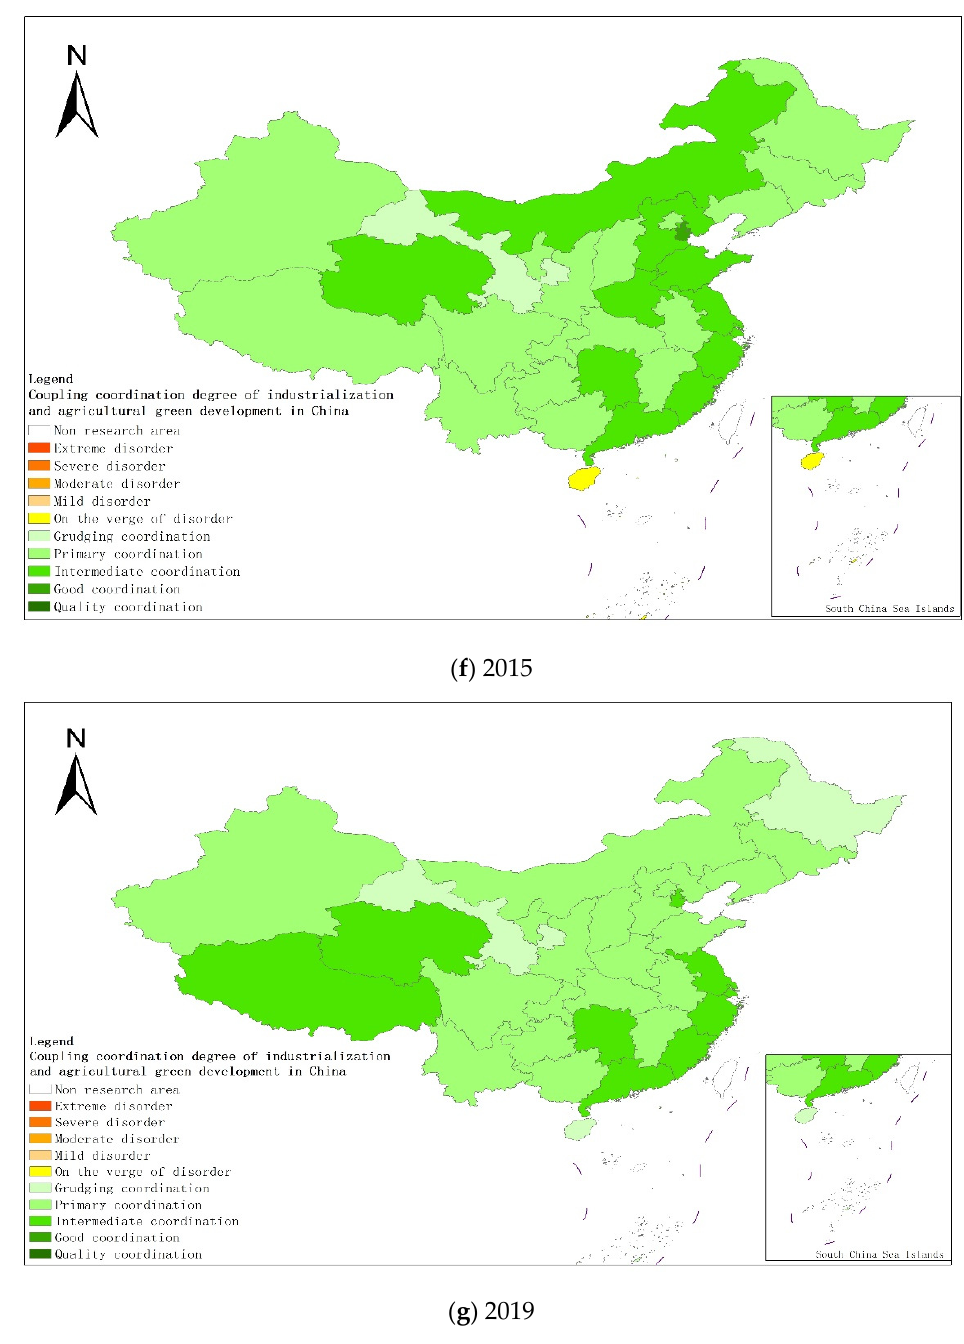
Figure 4. Coupling and coordination types of China’s industrialization and agricultural green development in some years ( a – g ). ( a ) 1990; ( b ) 1995; ( c ) 2000; ( d ) 2005; ( e ) 2010; ( f ) 2015; ( g ) 2019. Data Source: the authors calculated based on China Statistical Yearbook, China Industrial Statistical Yearbook, China Rural Statistical Yearbook, China Regional Economic Statistical Yearbook.